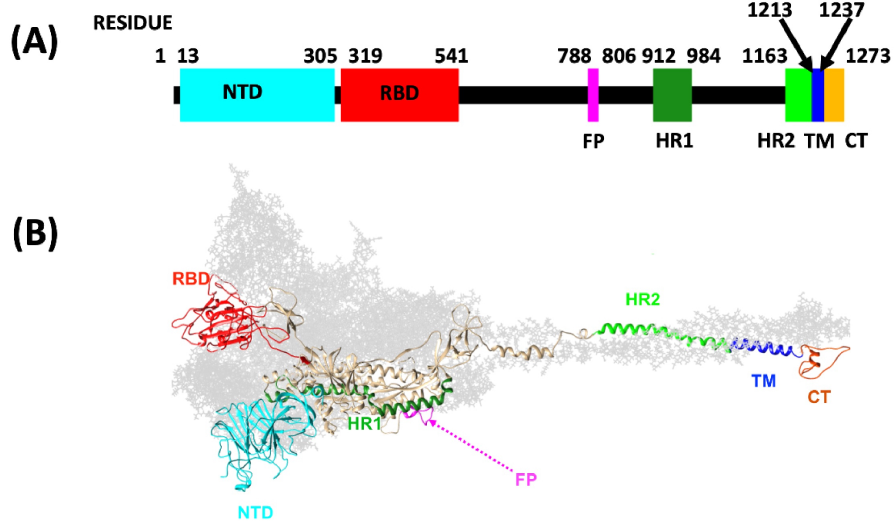
Fig 1. (A) Spike protein subunit S1 consists of the N-terminal domain NTD and the receptor binding domain RBD. The subunit S2 consists of the fusion peptide FP, two heptapeptide repeat sequences HR1 and HR2, the transmembrane domain TM and the cytoplasm domain tail CT. (B) A three-dimensional model of the full length closed conformation spike protein, based on the PDB structure 6VXX (closed state) and adapted from [30].